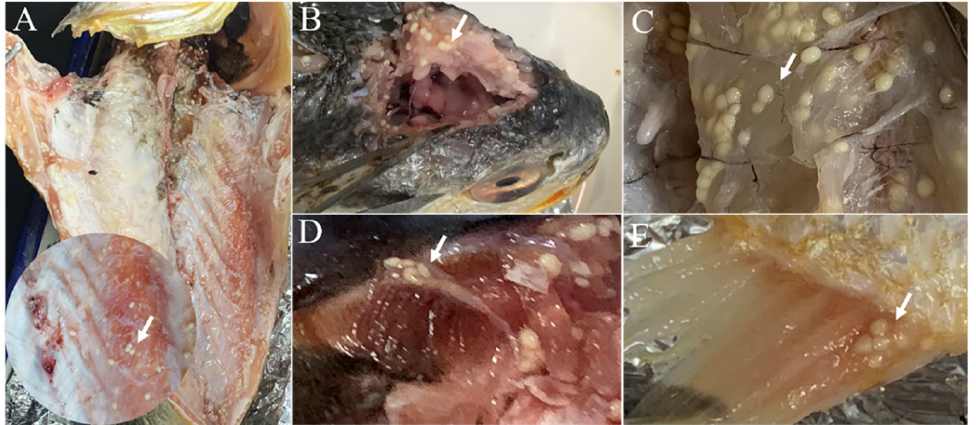
Figure 1. Main tissue and organs of large yellow croaker, Larimichthys crocea, with Kudoa infection. ( A ) Muscle with myoliquefaction. ( B ) Kudoa cysts on brain cartilage. ( C ) Kudoa cysts on dorsal muscle. ( D ) Kudoa cysts on gill arch. ( E ) Kudoa cyst on anal fin. White arrows: Kudoa cysts. Mature quadrate spores were observed with four equal spore valves, each contain-